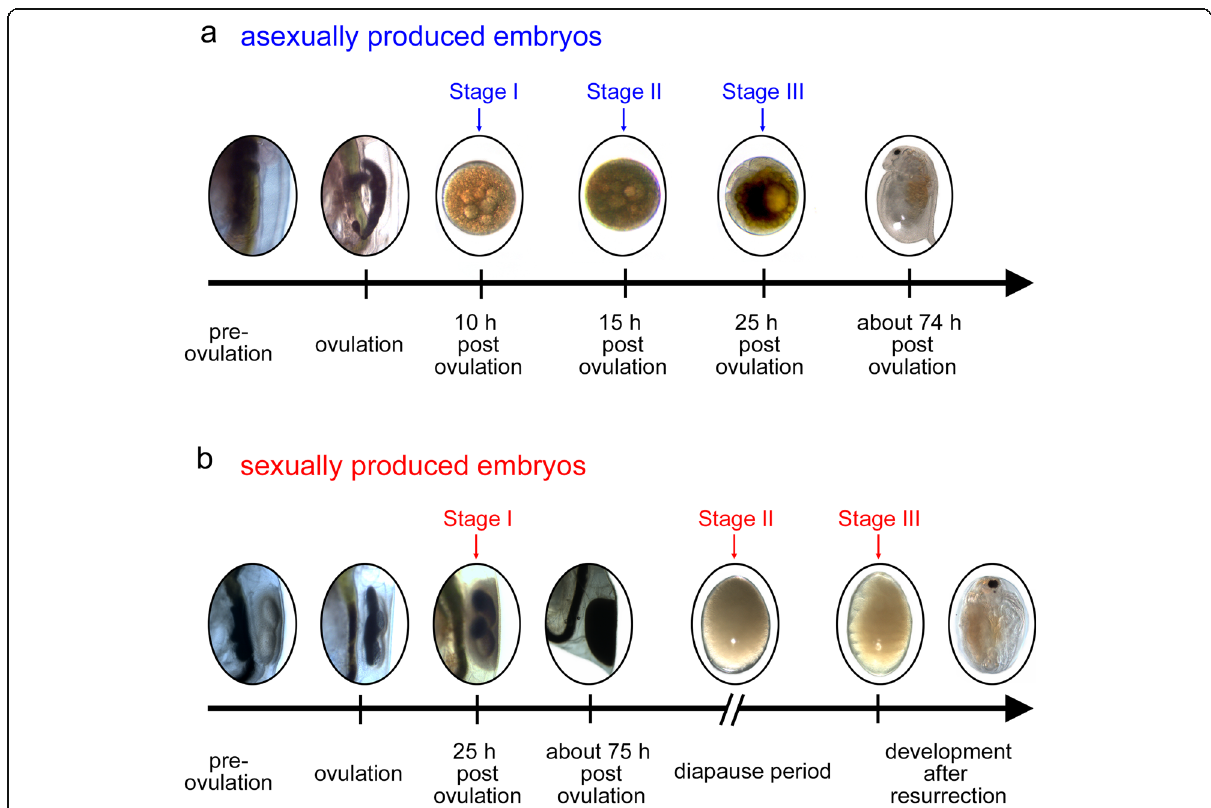
Fig. 5 Daphnia magna embryogenesis starting with germ cells still in the ovaries. Ovulation and deposition in the brood pouch and maturing ephippium over time in asexually ( a ) and sexually ( b ) produced embryos of Daphnia magna . Once (fertilized) germ cells are released from the ovaries, they are deposited in the maternal brood pouch (in asexually bred embryos) or in the developing ephippium (in sexually bred embryos). While asexually bred embryos develop directly, and first signs of morphological features are already observed 25 h post ovulation, sexually bred embryos are maintained in the sclerotizing and darkening ephippium. About 74 h post ovulation the mother molts and thereupon sheds the ephippium. The embryos in the ephippium have arrested in diapause already 50 h post ovulation. Development progresses upon diapause termination by exogenous factors. Stages indicate the time points used for fluorescent